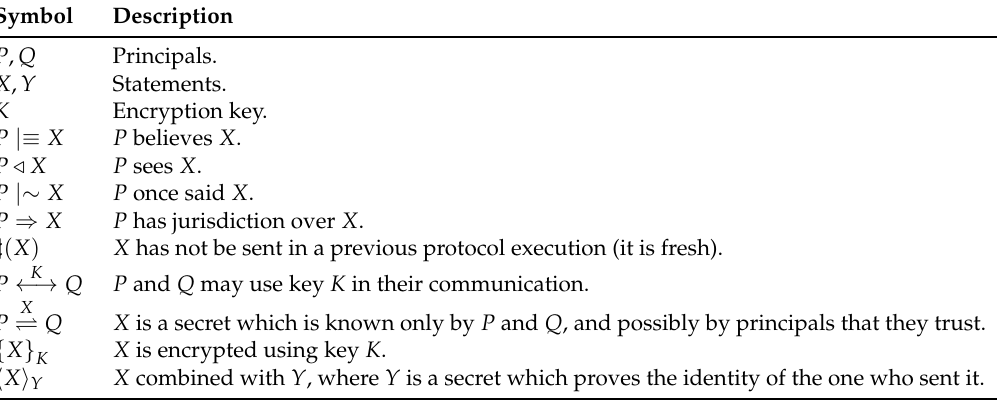
Table 2. Burrows–Abadi–Needham (BAN) logic notation.